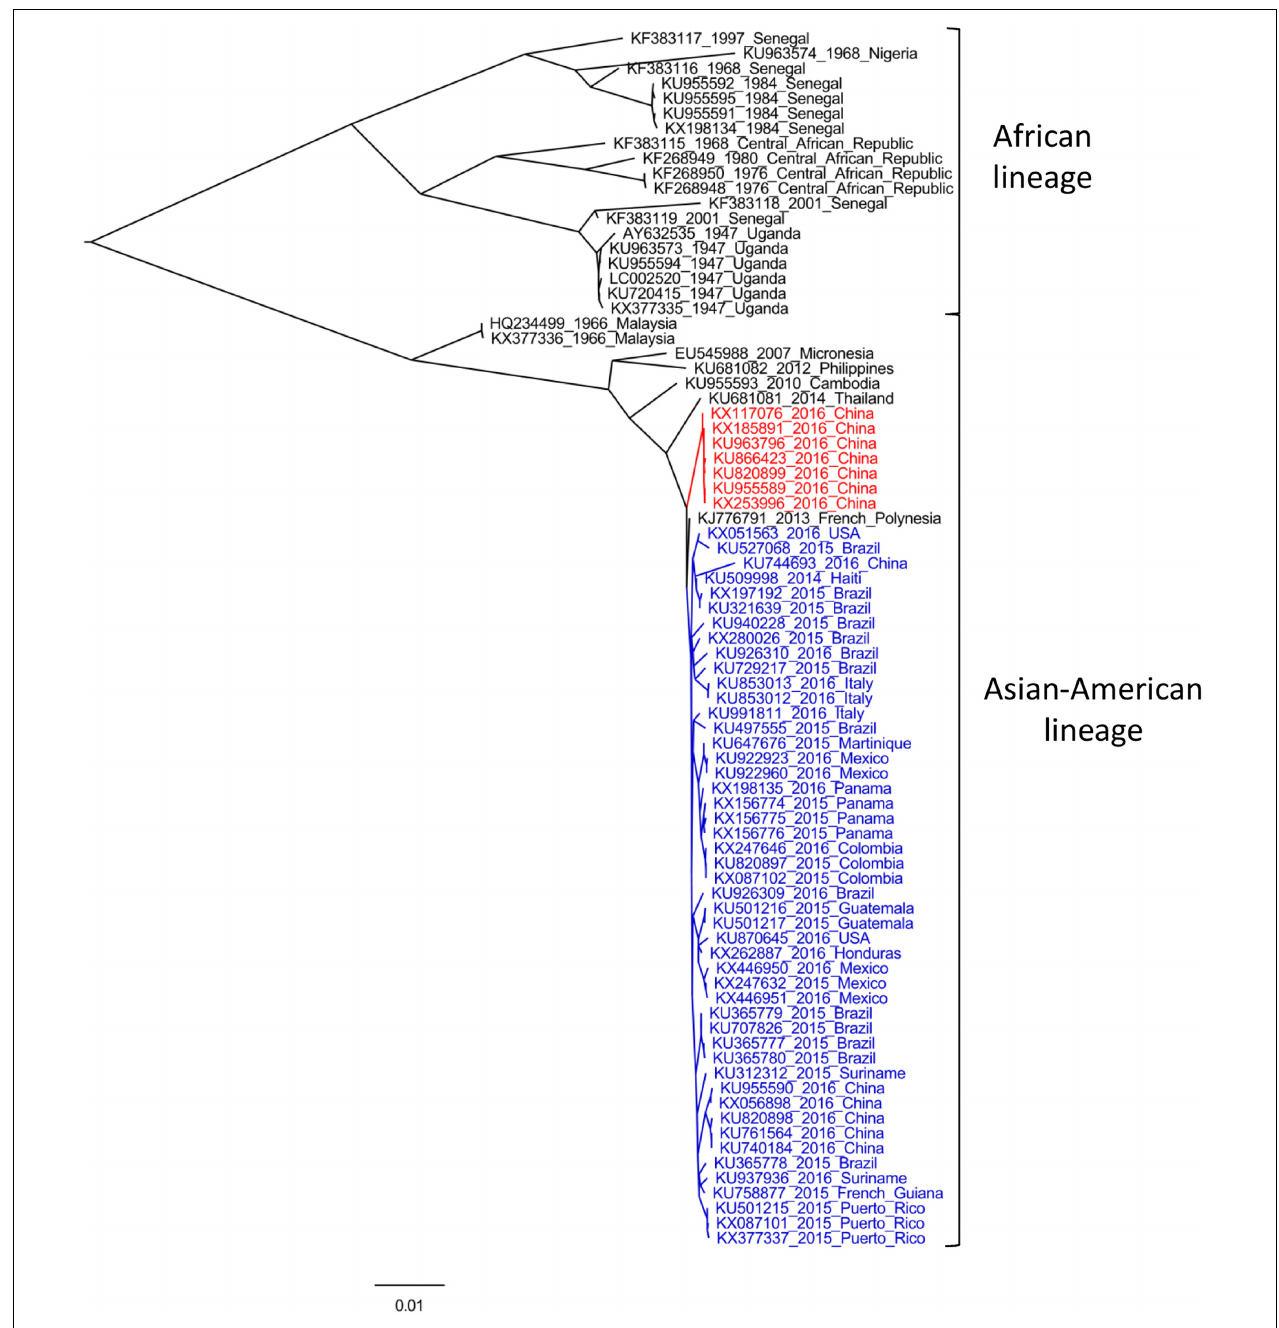
FIGURE 1 | Maximum-likelihood analysis of all complete ORF sequences of Zika virus (ZIKV) available. The phylogenetic tree was performed using PhyML software (Guindon et al., 2005) under a GTR + G + I substitution model, and edited with FigTree program v1.4.2 (available at: http://tree.bio.ed.ac.uk). Strains are indicated by their accession number, year and country of isolation. Sequences derived from variants isolated during current American outbreak and from imported strains from Fiji and Samoa (Deng et al., 2016; Zhang et al., 2016), are indicated in blue and red, respectively. Bootstrap values > 90% support major nodes but are not shown for visualization purpose. The bar at the bottom of the tree denotes nucleotide